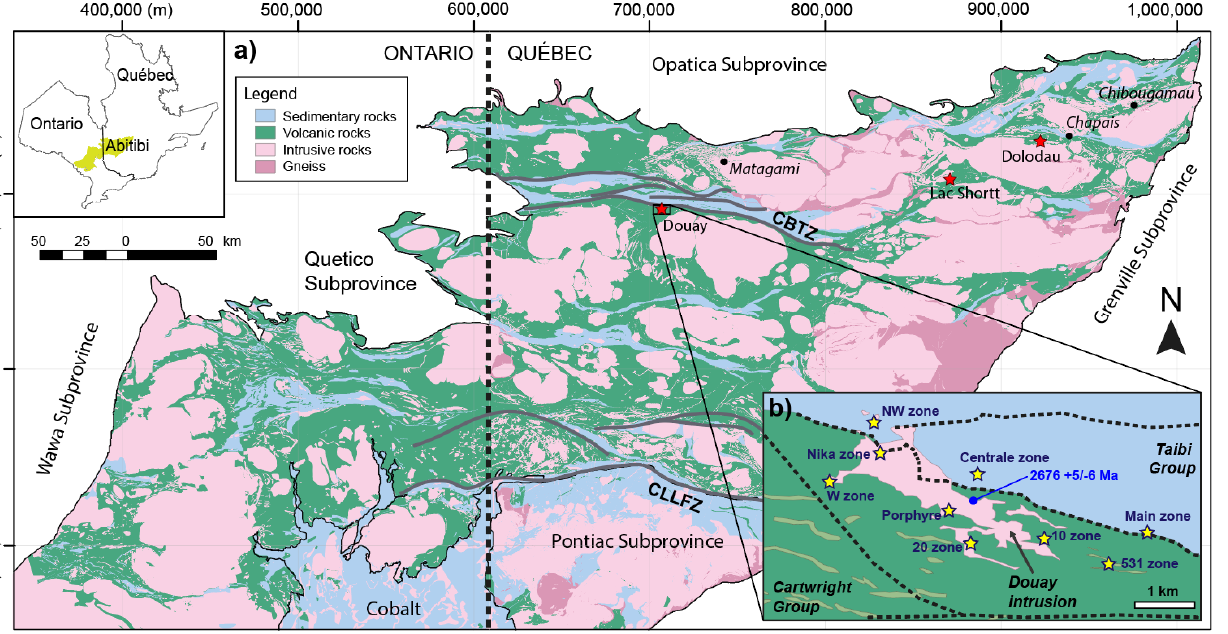
Figure 1. ( a ) Geological map of the Abitibi greenstone belt showing the distribution of the main lithologies. The map is modified from the Ministère de l’Énergie et des Ressources Naturelles of Québec (MERN), Sigeom dataset, and from the Ontario Geological Survey (OGS). The projection is UTM NAD83 Zone 17N. The red stars locate the main alkaline-carbonatite intrusive complexes of the Abitibi greenstone belt. Acronyms stand for the Casa Berardi Tectonic Zone (CBTZ) and the Cadillac–Larder Lake Fault Zone (CLLFZ). ( b ) Zoom on the Douay project, as mapped by Maple Gold Mines Ltd. (Vancouver, BC, Canada), showing the location of orebodies (yellow stars), the sample dated by Davis et al. [23] (blue dot), the main faults documented by Maple Gold Mine Ltd. (dashed lines), as well as the main lithologies, including the Douay intrusion, the Taibi Group, and the volcanic rocks (dark green) and interflow sedimentary rocks (light green) of the Cartwright Group.